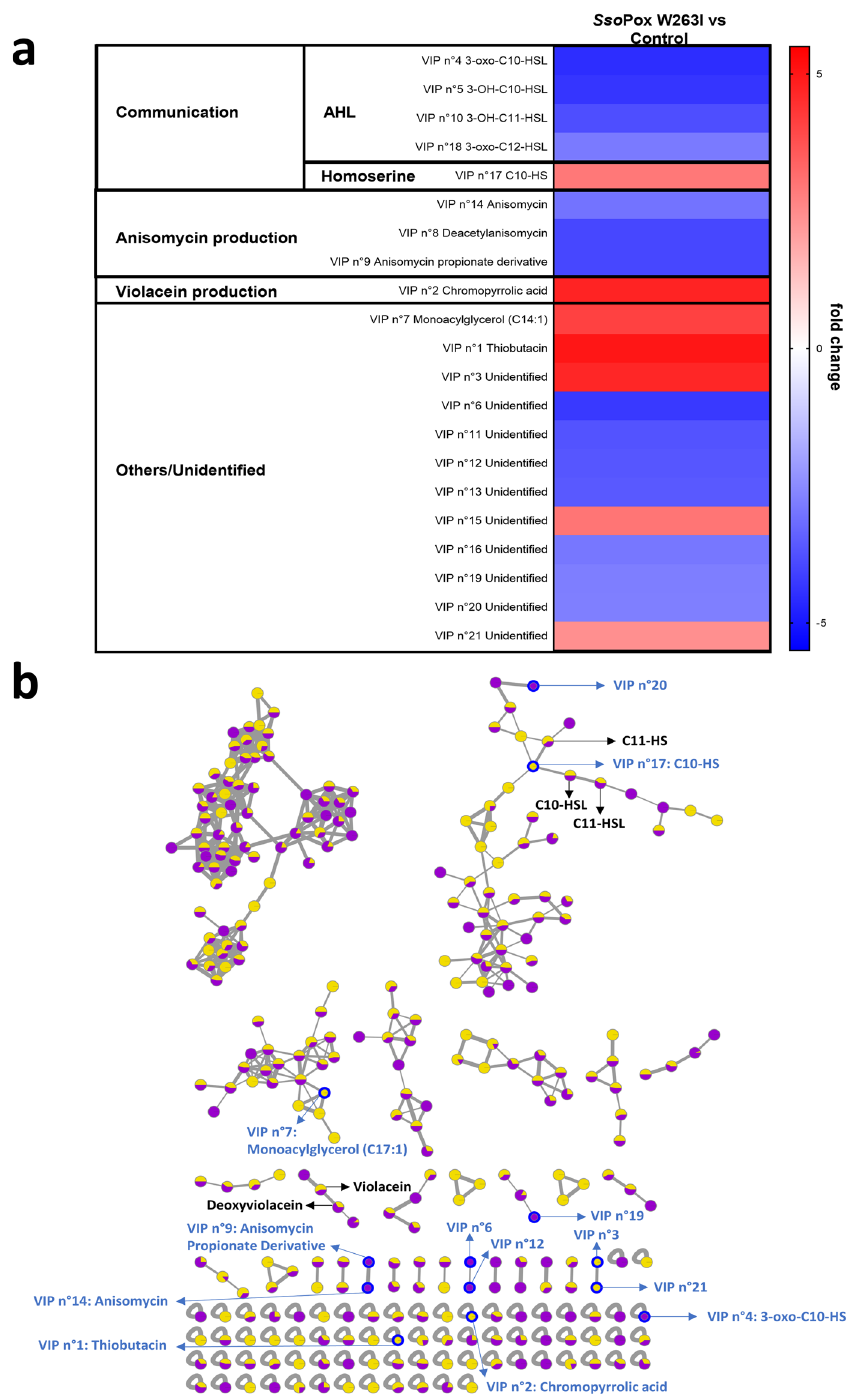
Fig. 3 Metabolome analysis of C. violaceum cultures with and without lactonase treatment. a Impact of Sso Pox W263I treatment on C. violaceum metabolite production. Heatmap represents the fold change of the 21 most discriminating metabolites (identi fi ed by their VIP score through the PLS-DA analysis) between Sso Pox W263I (0.5 mg ml − 1 ) treated samples and untreated ones as negative controls. Down- and upregulated metabolite expressions are presented in blue and red, respectively. b Molecular network of LC-MS metabolomic data and identi fi cation of molecules of interest in clusters. VIPs are circled in blue. For each metabolite, color ratio corresponds to its relative abundance in treated (yellow) and untreated (purple)